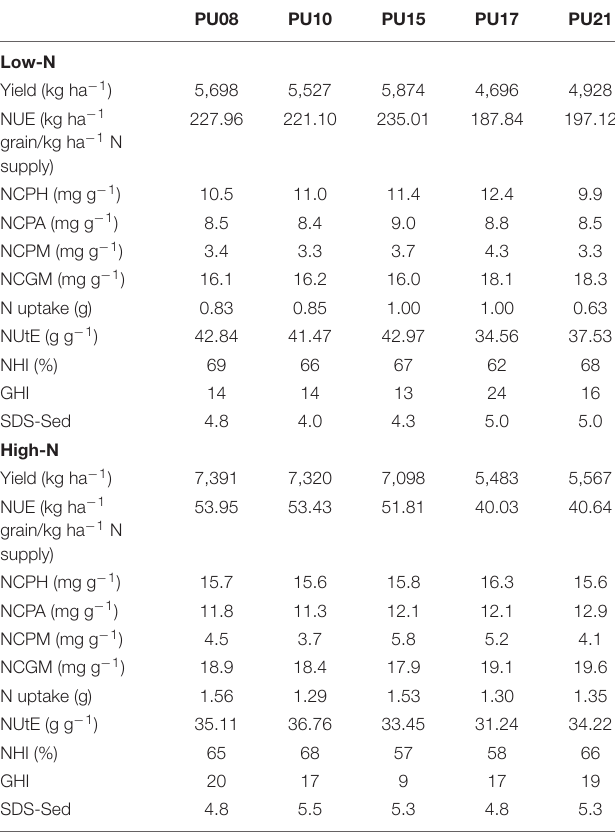
TABLE 2 | Nitrogen analysis and grain quality assessment of five subset lines. PU08 PU10 PU15 PU17 PU21